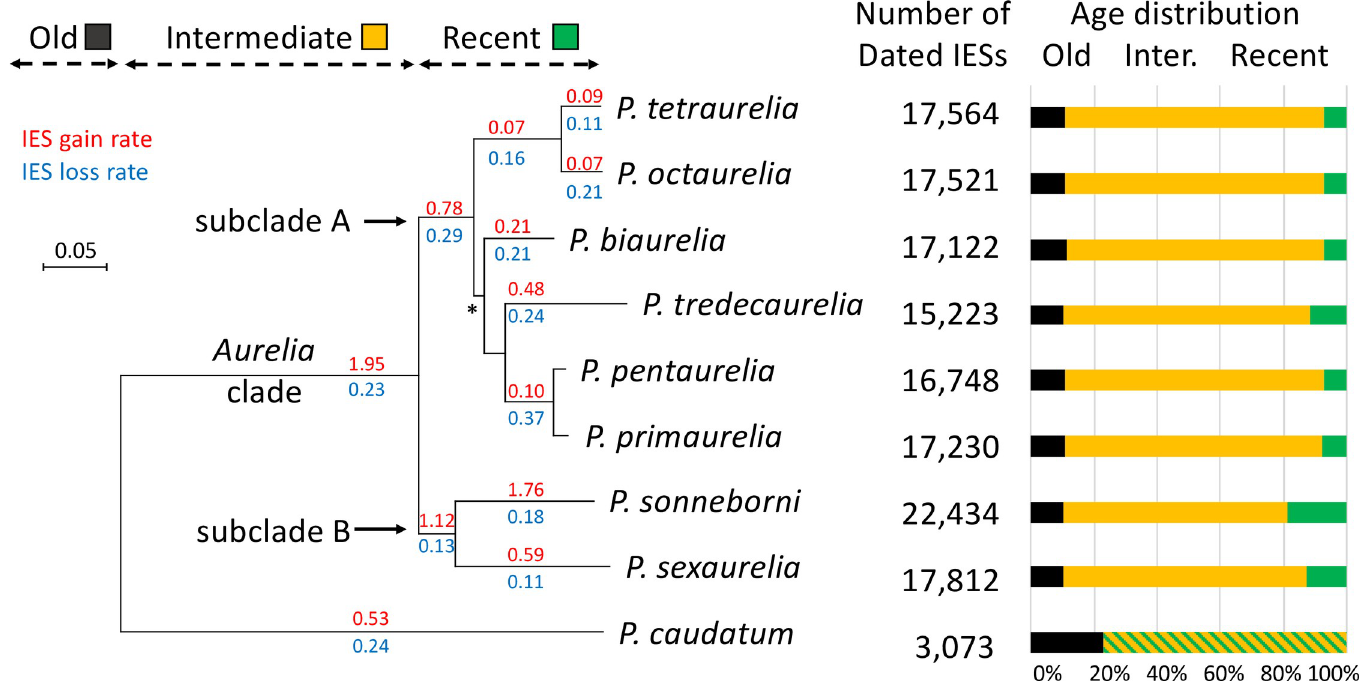
Fig 1. Dynamics of IES insertion/loss in Paramecium . The species phylogeny was reconstructed from a concatenated alignment of 1,061 single-copy genes. All internal branches are supported by 100% bootstrap values (except branch � : bootstrap support = 83%). The age of IESs located within coding regions was inferred from the pattern of presence/absence within gene family alignments ( N = 13,617 gene families). Only IESs present within well-aligned regions were included in this analysis. The number of dated IESs and the fraction predicted to be old (predating the divergence between P . caudatum and the P . aurelia lineages), intermediate (before the radiation of the P . aurelia complex), or recent are reported for each species. Rates of IES gain (in red) and loss (in blue) were estimated along each branch using a Bayesian approach. Gain rates are expressed per kb per unit of time (using the branch length—in substitutions per site—as a proxy for time). Loss rates are expressed per IES per unit of time (see S8 Fig for more details on the measure of gain/loss rates). NB: Estimates of loss rate along terminal branches of the phylogeny also include false negatives (i.e., IESs that are present but that have not been detected) and hence may be overestimated. The data underlying this figure may be found at https://doi.org/10.5281/zenodo.4836464. IES, internal AU : AbbreviationlistshavebeencompiledforthoseusedinFigs 1 (cid:0) 5 : Pleaseverifythatallentriesarecorrect : eliminated sequence.